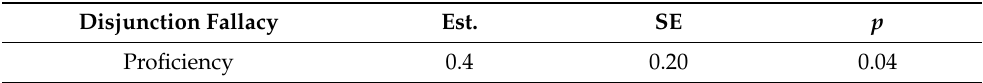
Table 16. A Disjunction fallacy regression, Spanish items by proficiency.